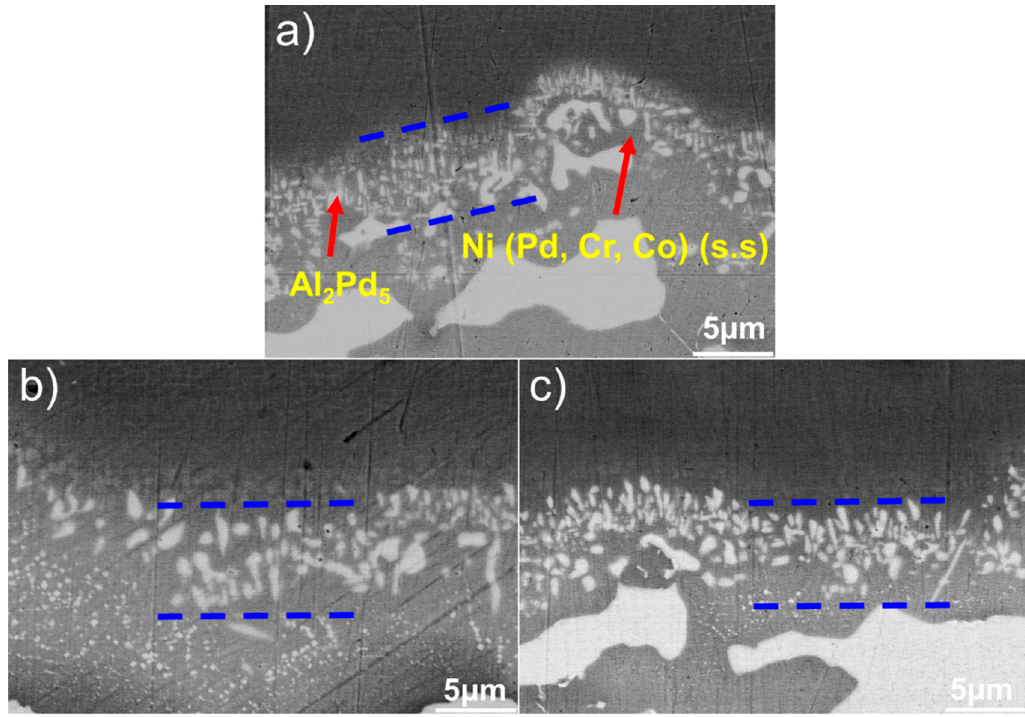
Figure 5. SEM back-scattered electron images of the zone 2 in the DD98M/Pd-Si/DD98M joints brazed at different temperatures for 30 min: ( a ) 1020 ° C, ( b ) 1060 ° C, and ( c ) 1100 ° C.